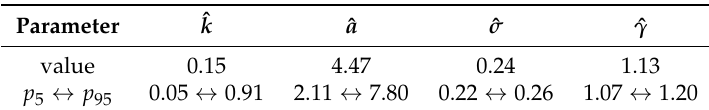
Table 2. US Interest Rate: estimated CKLS parameters, as well as the limits of 90% covering interval sandwiched between the 5% and 95% percentiles.